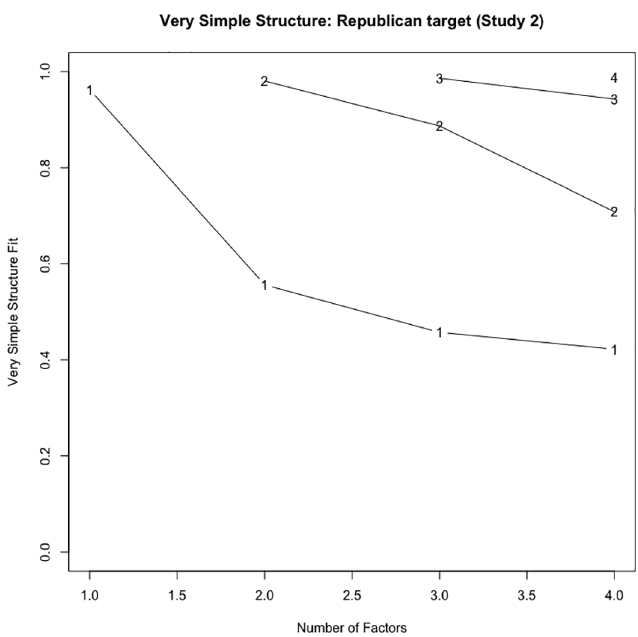
Figure A.4. Very simple structure analysis of Republican target trait ratings in Study 2.